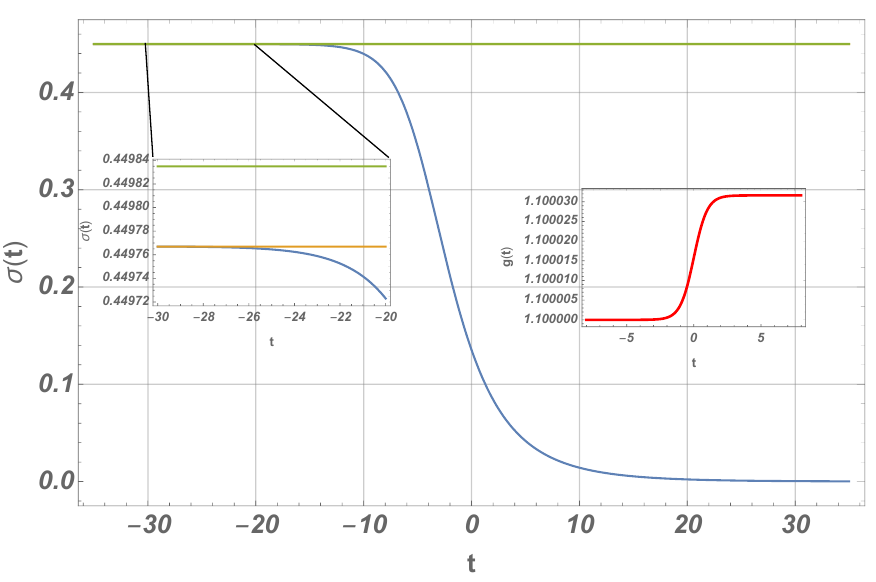
Figure 1 . Plot of (cid:27) ( t ) as a function of time. We have chosen cut-o(cid:11), (cid:3) = 3 with g i = 1 : 10 ; g f = 1 : 1 + 10 (cid:0) 4 : 5 ; (cid:14)t = 10, the red inset curve shows g ( t ) vs. t . In the zoomed inset, the orange line corresponds to the equilibrium (cid:27) for g = g i and the green corresponds to (cid:27) for g = g f